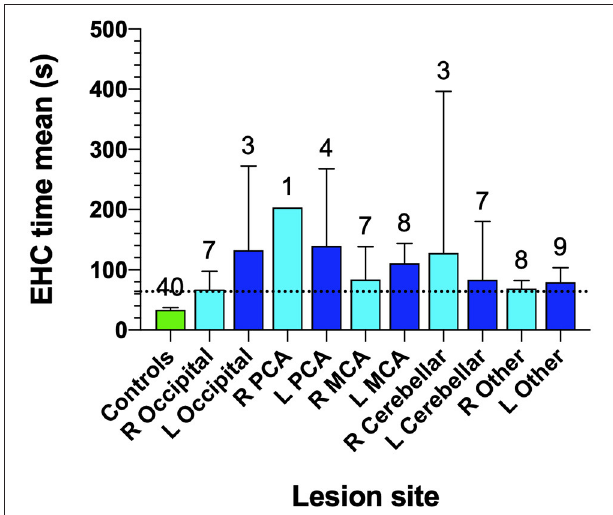
FIGURE 6 | Eye-hand coordination for controls and site of lesion in AIS patients. Cohort number is shown at the top of each bar. Bars identify mean EHC time for various lesion locations and error bars are SD. The horizontal dotted line identifies the 97.5th percentile for controls.